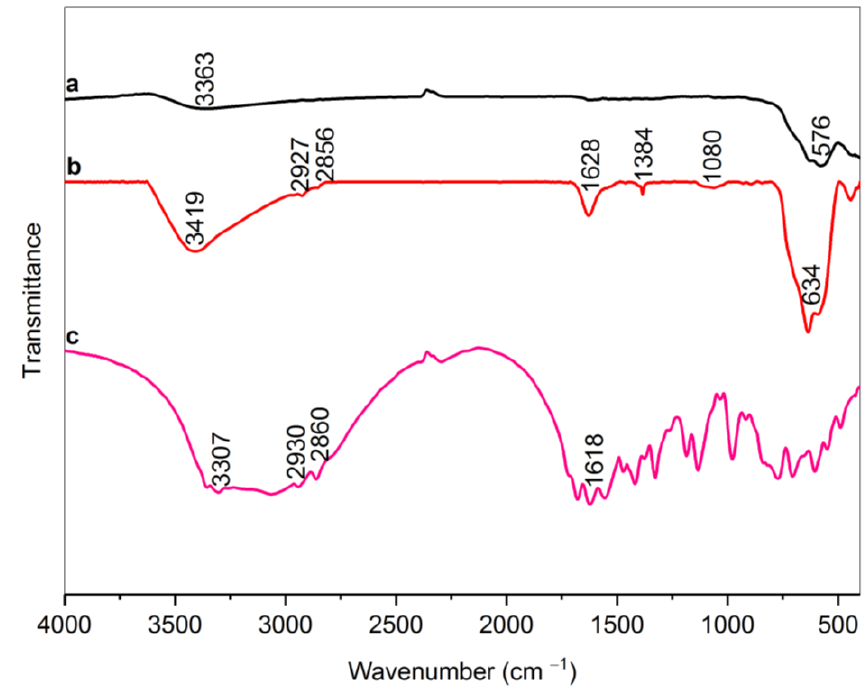
Figure 1. FT-IR spectra of bare MNPs (a), RMNPs (b), and Arg (c).